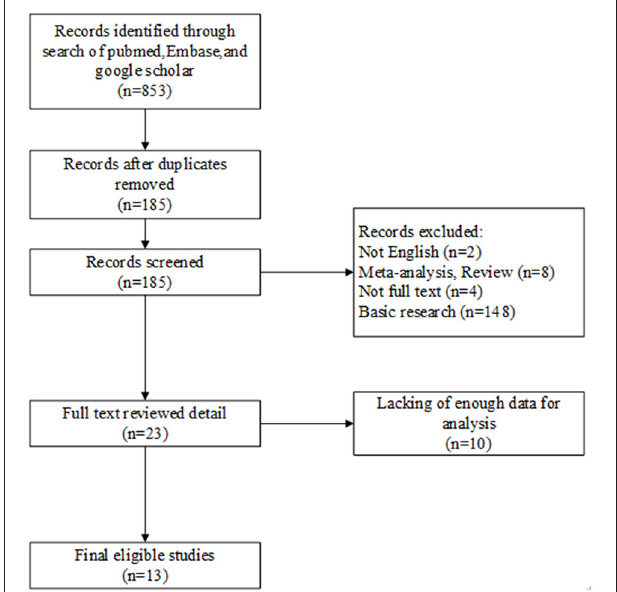
FIGURE 1 | Flow chart of studies in the analysis.